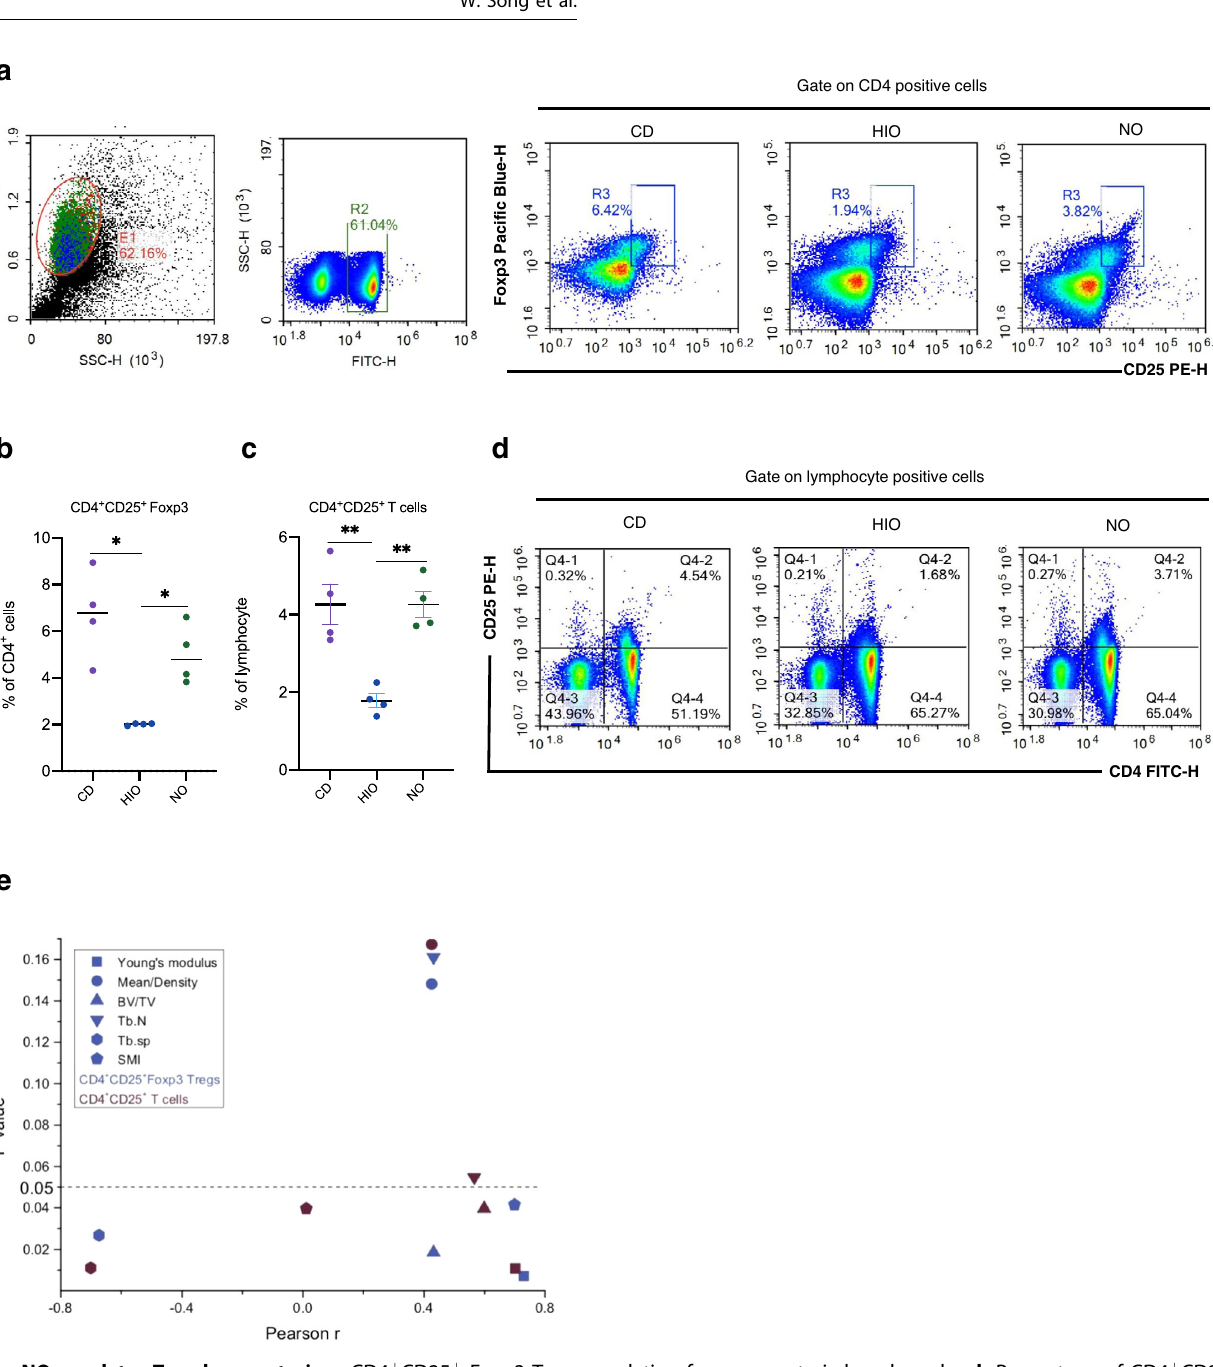
Fig. 4 NO regulates Treg homeostasis. a CD4 + CD25 + Foxp3 Treg population from mesenteric lymph nodes. b Percentage of CD4 + CD25 + Foxp3 Tregs. c Percentage of CD4 + CD25 + T cell. d CD4 + CD25 + T cells population. e Correlation between CD4 + CD25 + Foxp3 Tregs and CD4 + CD25 + T cells against the bone parameters of Young ’ s modules, Mean/Density of cortical bone, BV/TV of cancellous, Tb.N of trabecula, Tb.sp of trabecula and SMI of trabecula. n = 4 mice per group. Correlations were performed using Pearson test between two different locations of recipients and kinds of genus by “ R ” packet. Data are presented as means ± SEM. One-way ANOVA was used to analyze signi fi cant differences. * p < 0.05, ** p <